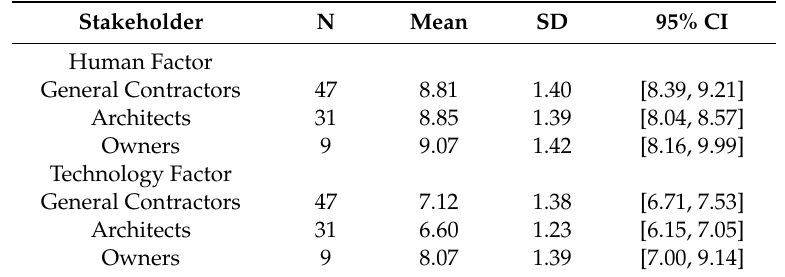
Table 6. Human and Technology Factor Descriptive Statistics by Stakeholder (RQ3).